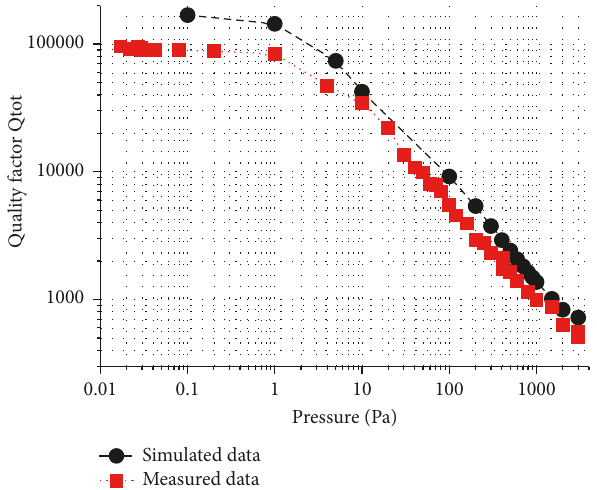
with pressure P at the tot